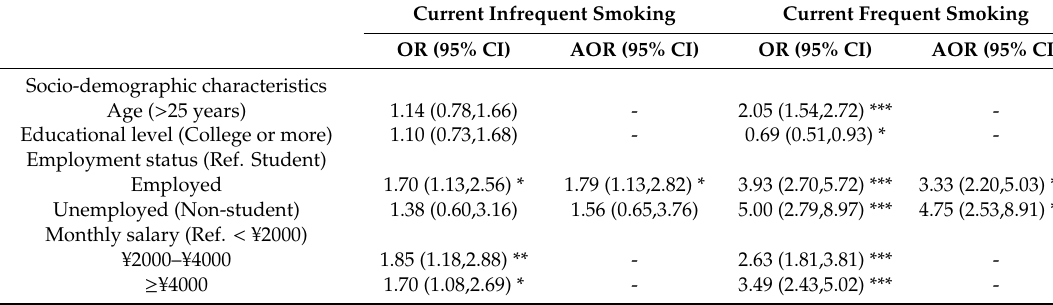
Table 3. Univariable and multinomial analyses: factors associated with current smoking with the current non-smokers group as